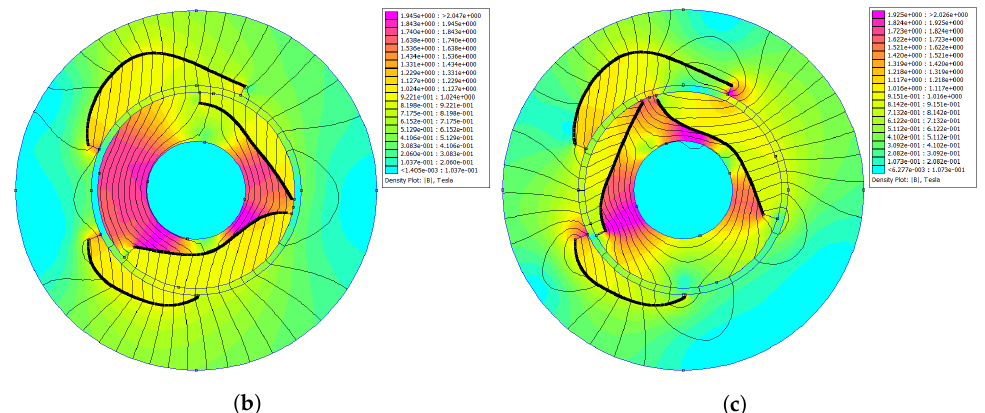
Figure 11. Result of free shape optimization using spline formulation, for conjugate cam-follower reference torque profile. ( a ) Resulting design geometry. ( b ) magnetostatic simulation result for magnetic flux density in magnetic spring at θ = 10 ◦ . ( c ) magnetostatic simulation result for magnetic flux density in magnetic spring at θ = 130 ◦ .